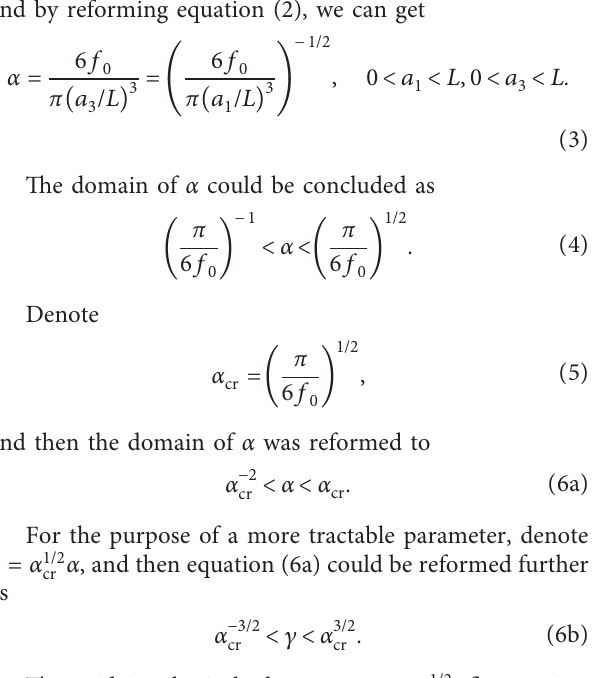
Figure 4: Voided RVE.